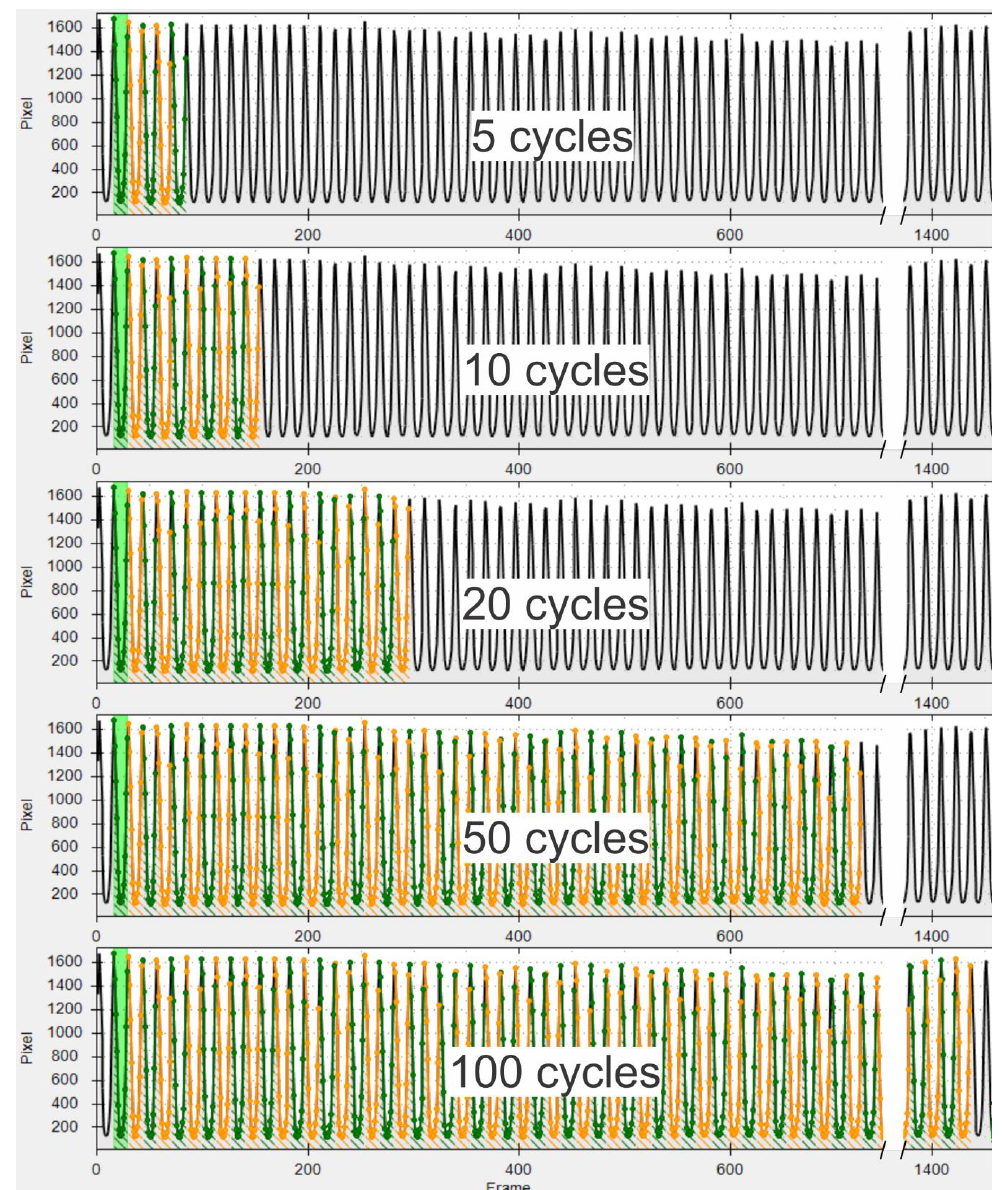
Figure 3. For each segmented GAW 5 sets of consecutive cycles are chosen for analysis.